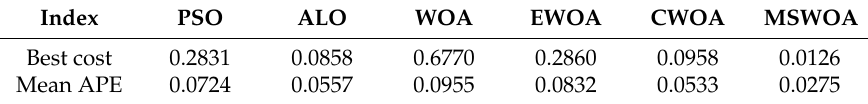
Table 11. Mean best cost and APE under no-load condition.